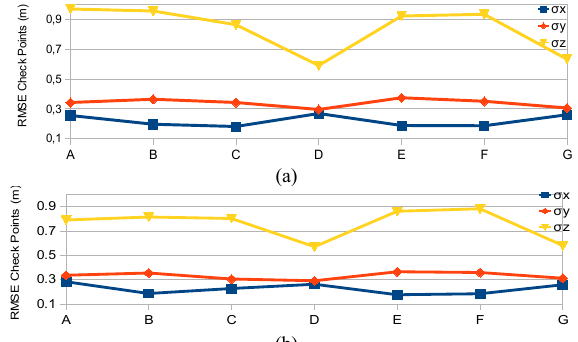
Figure 10. RMSE in the check points coordinates obtained in a bundle adjustment with 3 virtual images generated with parameters obtained in the experiments: (a) without and (b) with scale correction in the right